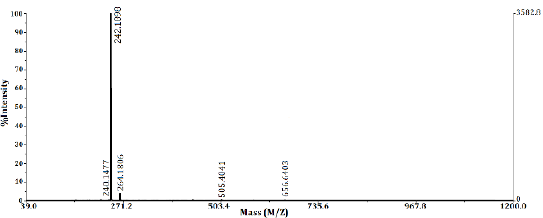
Figure 5. Mass spectrum of red product suggest AEW-1 (Mr 241) with Electro Spray ionization (ESI) method, positive ion mode. The spectrum showed m/z 242[M + H] +